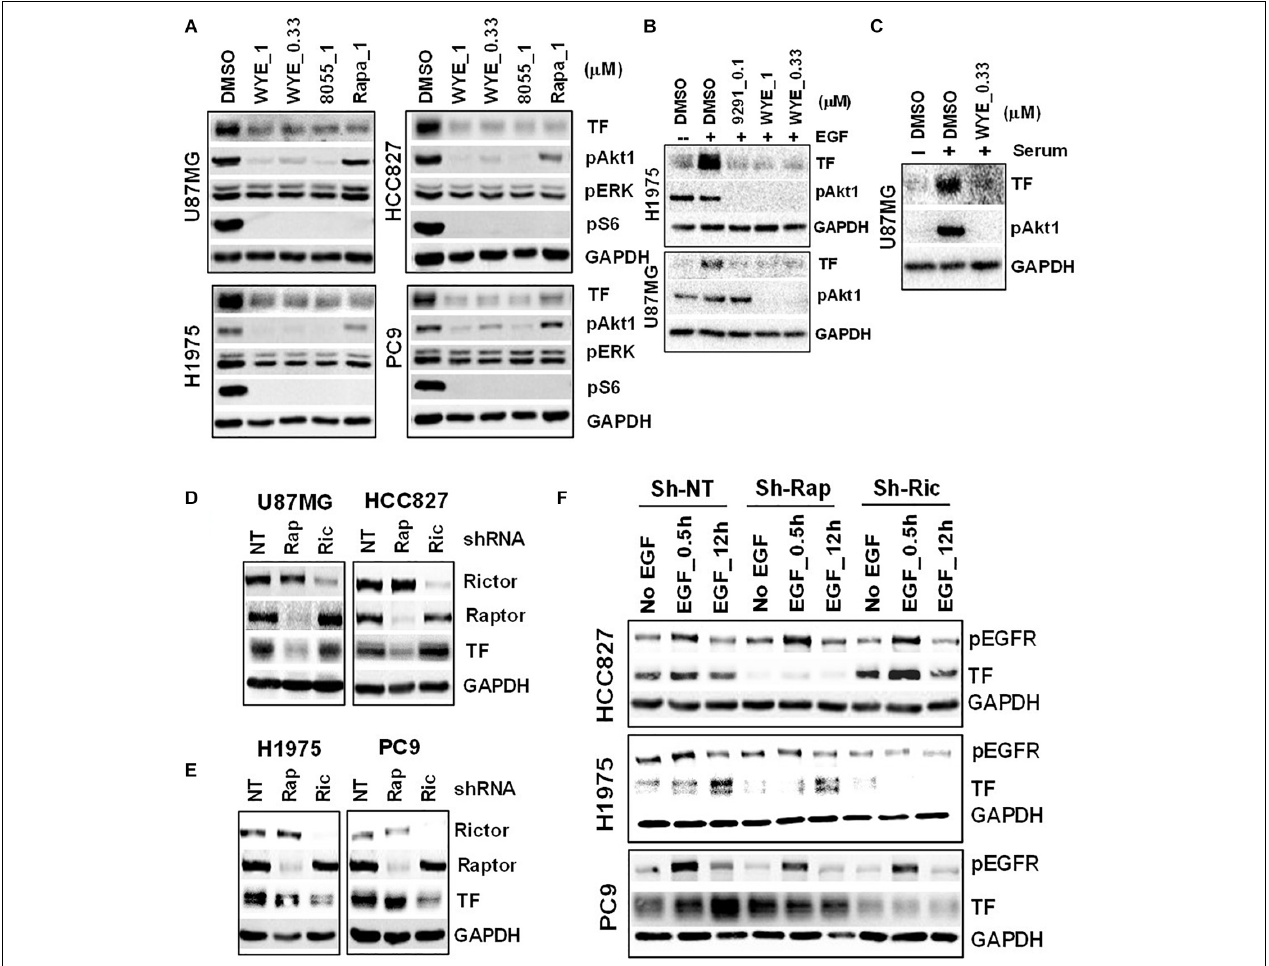
FIGURE 2 | Mechanistic target of rapamycin (mTOR) promotes TF overexpression in EGFR-mut tumors. (A) mTOR inhibitor WYE-132 and AZD8055 decreased TF expression in four indicated cell lines. The indicated cells were treated for 24 h in full growth medium followed by immunoblotting. (B) The indicated cells were serum-starved then stimulated with 50 ng/mL EGF without or with inhibitor for 24 h. (C) Serum-starved U87MG cells were stimulated with 10% serum without or with WYE-132 for 12 h and immunoblotted. (D,E) The indicated cell lines were infected with pGIPZ-shRNA encoding lentivirus, incubated for 6–7 days in full-growth medium and immunoblotted. (F) Cells as in D and E were serum-starved, stimulated with EGF and